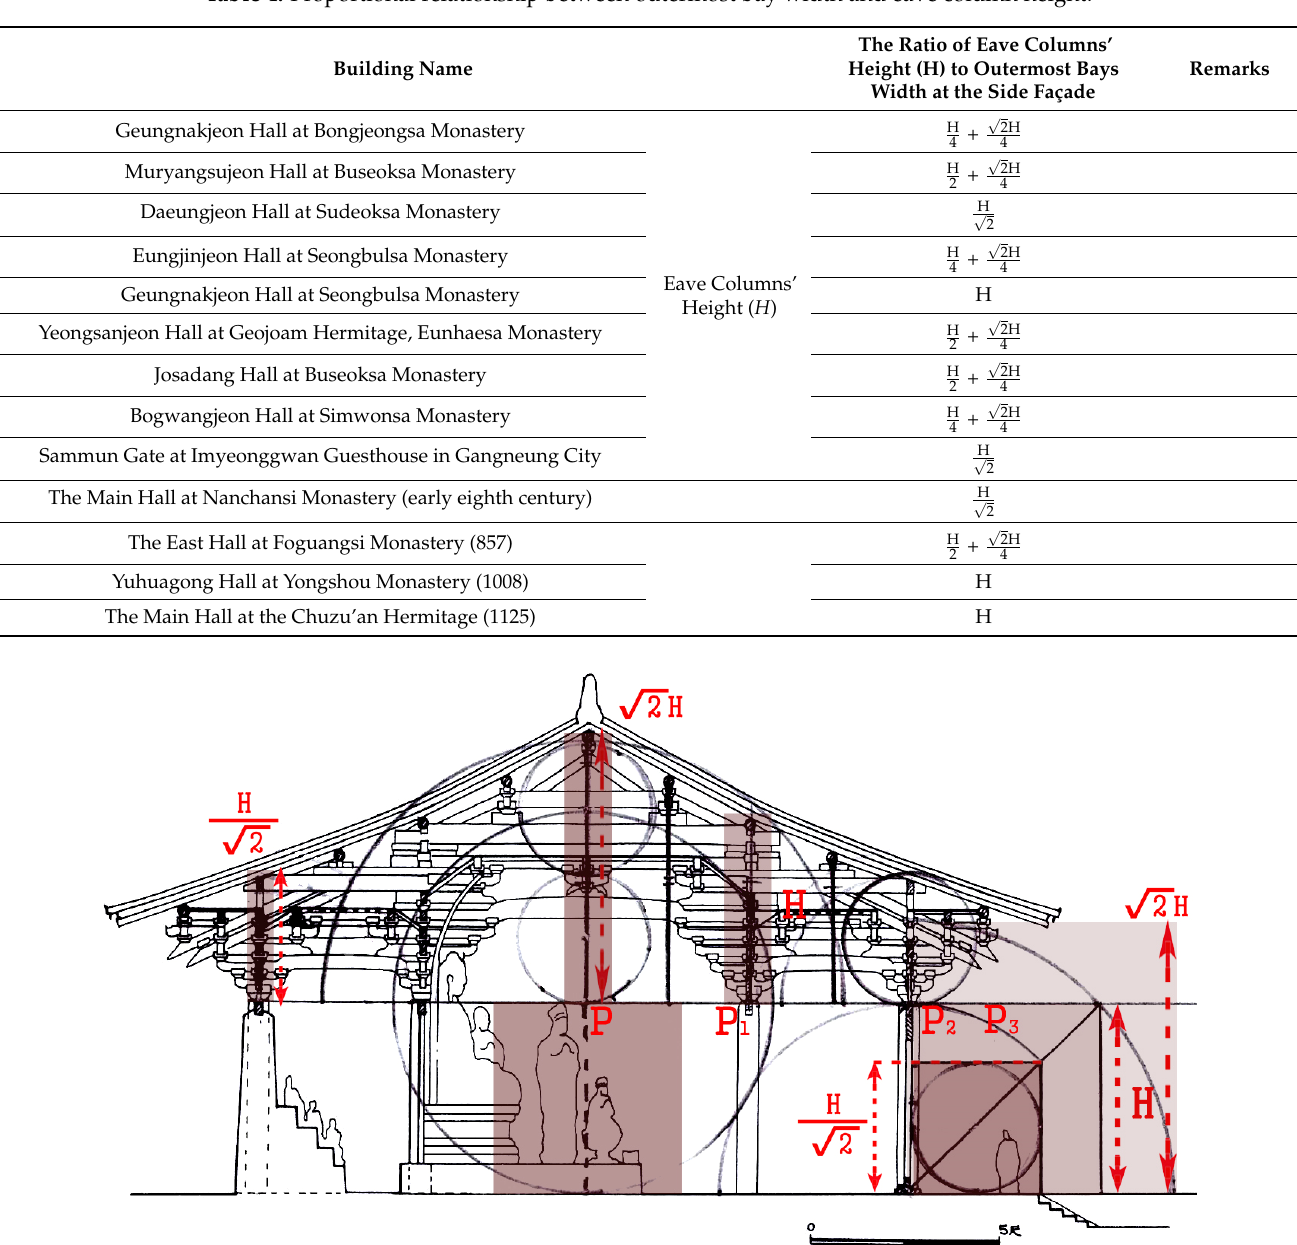
Table 4. Proportional relationship between outermost bay width and eave column height.